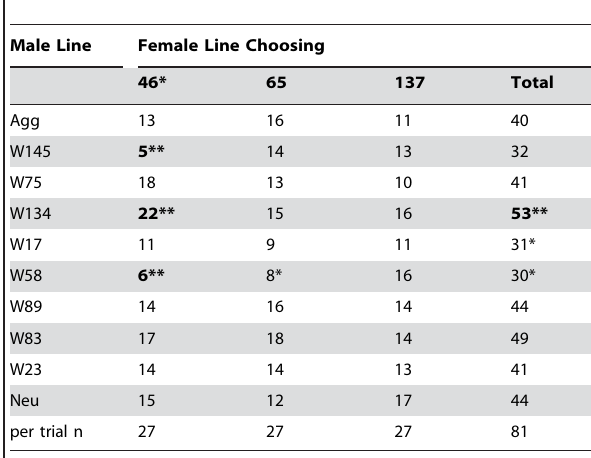
Table 2. Relative mating success among inbred lines of D. melanogaster .